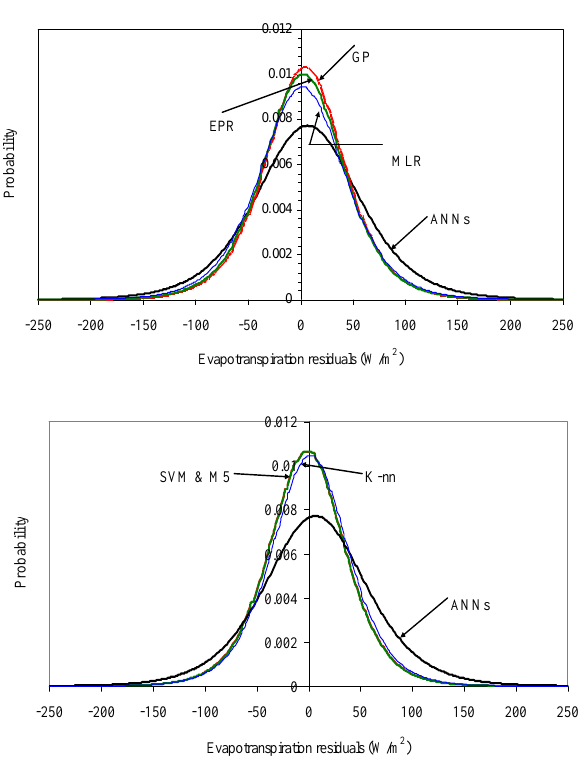
Fig. 6. Probability distribution of the 12 model residuals of all tech- niques (evapotranspiration case study).